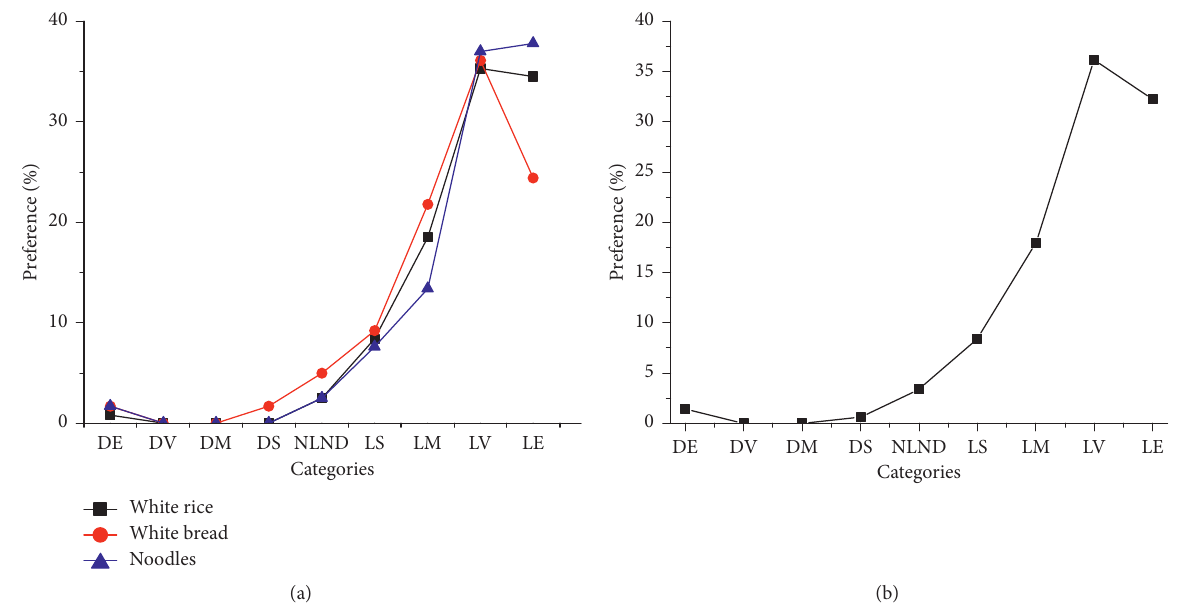
Figure 12: Food preference results. (a) Each cereals group food. (b) Cereals group as a